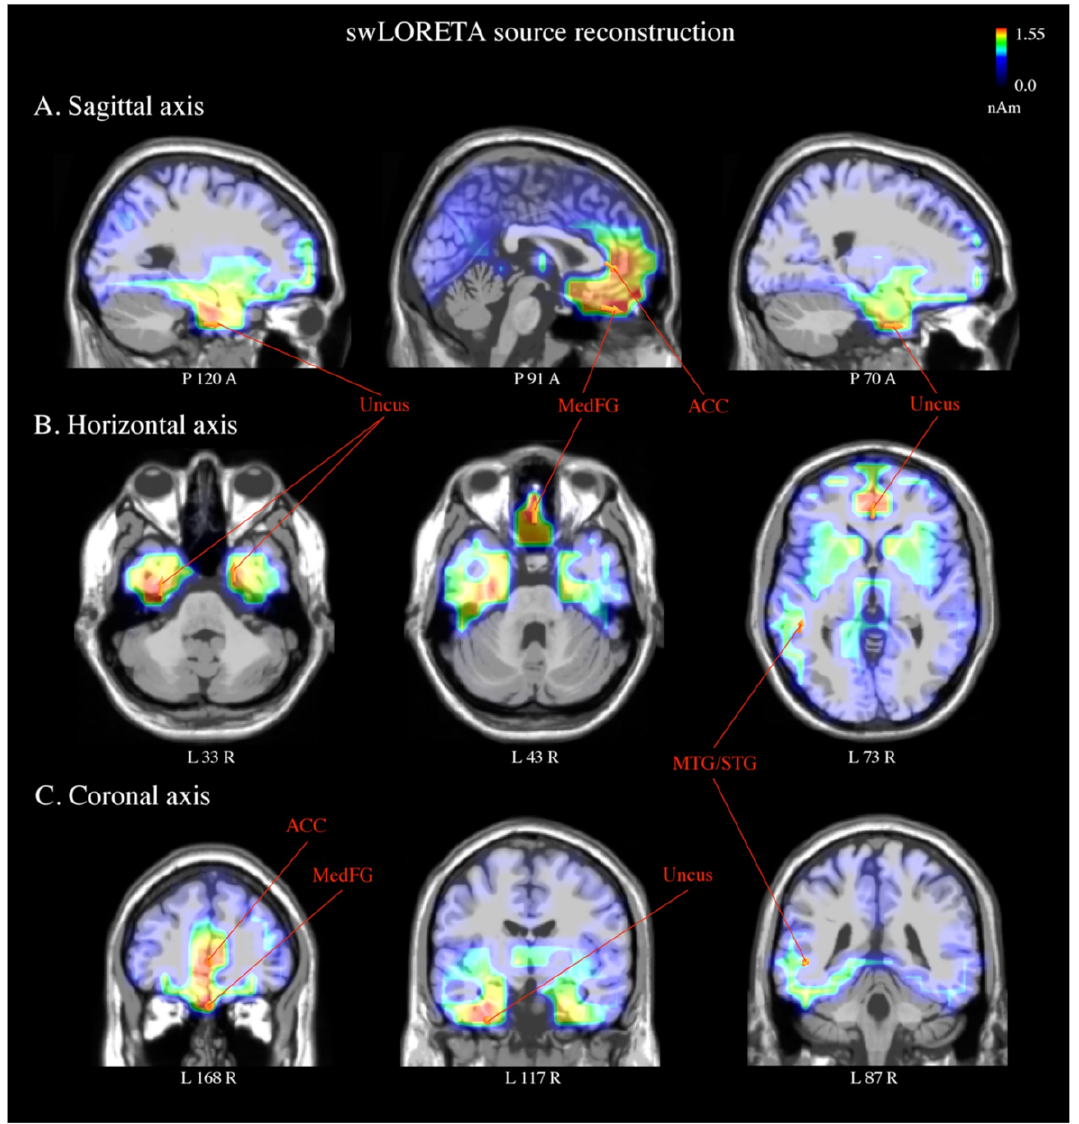
Figure 9. Standardized weighted low-resolution electromagnetic tomography (swLORETA) source reconstruction of surface potentials in the SN time windows. SwLORETA performed on the grand-average waveforms of the di ff erence wave (target minus non-target) in the time window of the SN component (240–280 ms). The sagittal ( A ), horizontal ( B ), and coronal ( C ) anatomical planes of the brain are shown. The engagement of limbic regions is visible, which includes the right anterior cingulate cortex (ACC, BA 24), medial frontal gyrus (MedFG, BA 11), and uncus, bilaterally (BA 28 / 36). Active dipoles in the left middle / superior temporal gyrus (MTG / STG, BA 22) and inferior frontal / precentral gyrus (IFG, BA 9 / 6) are also shown. The strongest magnitude values of the signal (nAm) are presented in